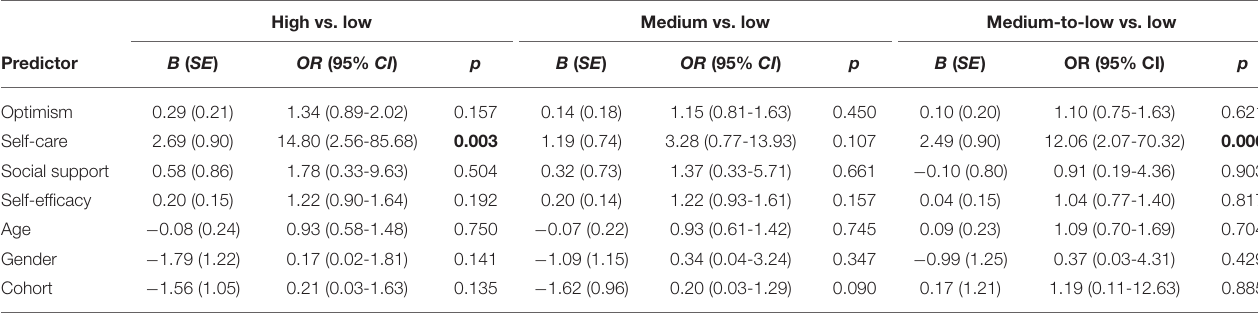
TABLE 3 | Multinomial logistic regression results for predicting resilient functioning trajectory